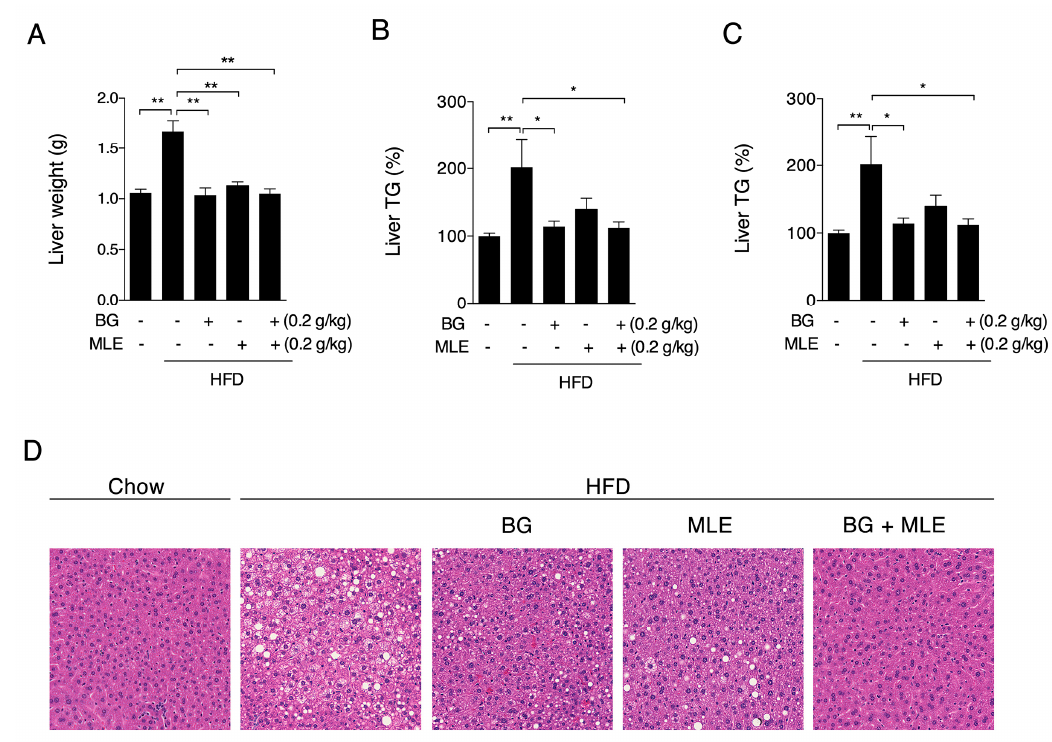
Figure 5. Effects of BG and MLE on liver lipids. Liver weight ( A ); liver TG ( B ); liver CHO ( C ); and HE staining of liver tissue ( D ) in male C57BL/6 mice fed a control diet or a high-fat diet supplemented with BG or/and MLE for 12 weeks. The data are the mean ± SEM, n = 10. * p < 0.05, ** p < 0.01 vs. related control.